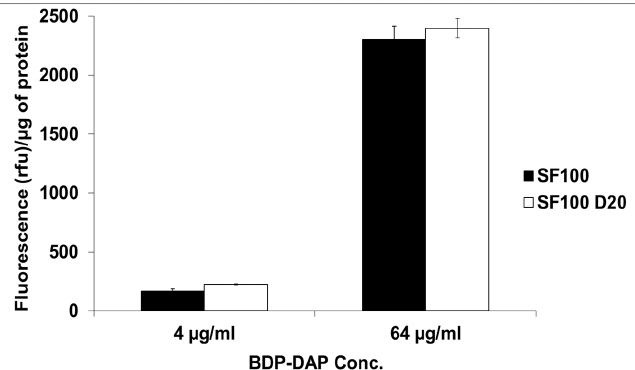
Figure 2. Bodipy-DAP (BDP-DAP) Binding DAP-S SF100 parental versus DAP-R SF100 D20 S. mitis-oralis